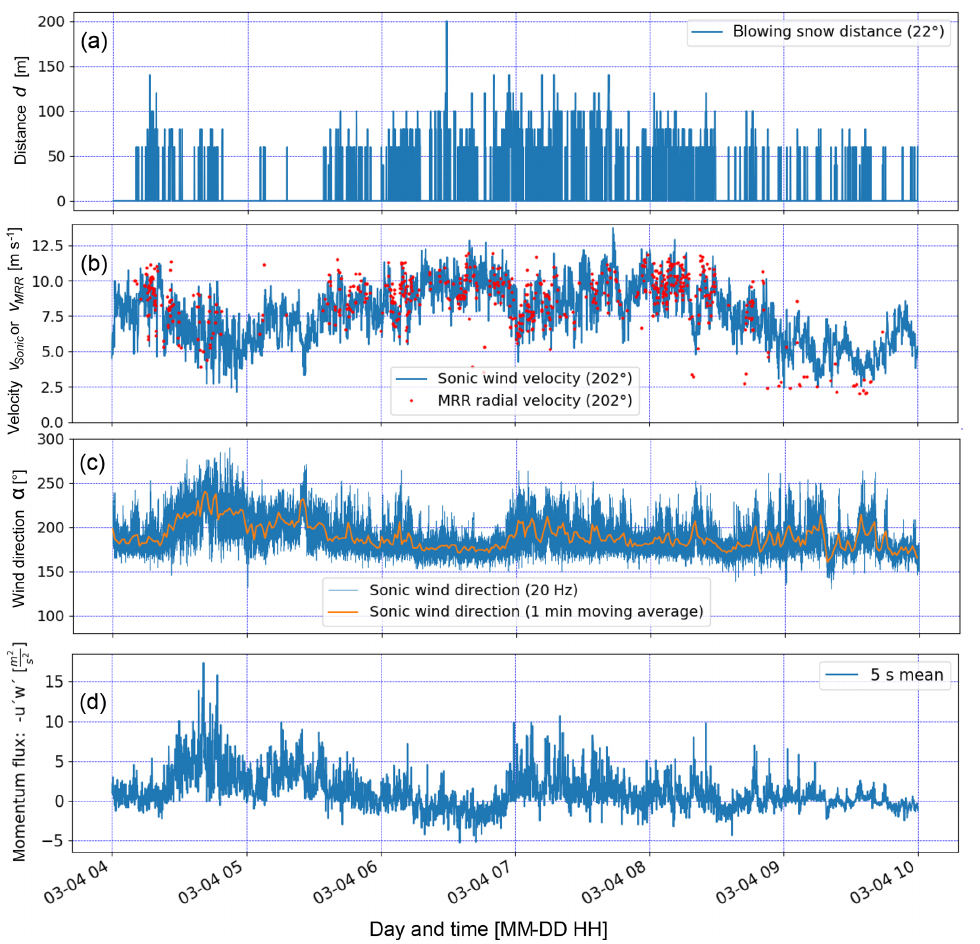
Figure 5. (a) Temporal evolution of the horizontal transport distance of all blowing snow events of EP1 (4 March, 04:00–10:00UTC + 1). (b) Wind velocity parallel to the MRR direction (202 ◦ ) measured with the Sonic compared to the close range (20–40m) blowing snow radial velocities measured with the MRR (see Fig. 4a). (c) Wind direction (mainly 180–220 ◦ ) and (d) momentum flux − u (cid:48) w (cid:48) calculated using the Sonic